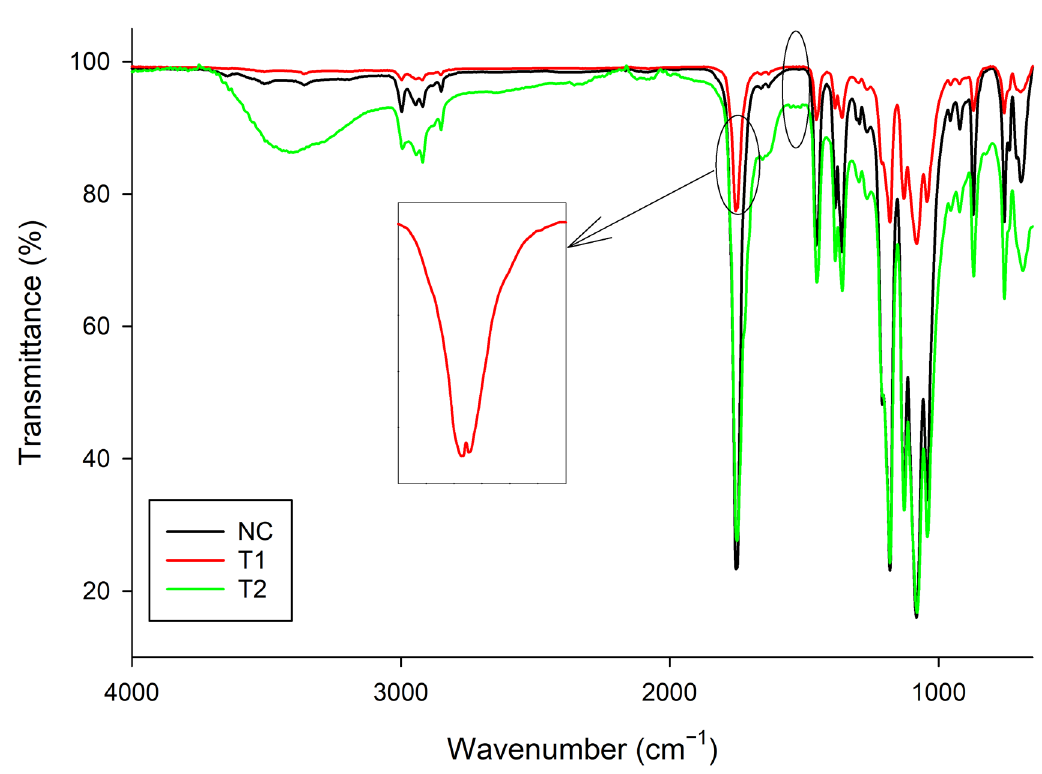
Figure 5. ATRIR spectra of NC, T1 and T2 samples.